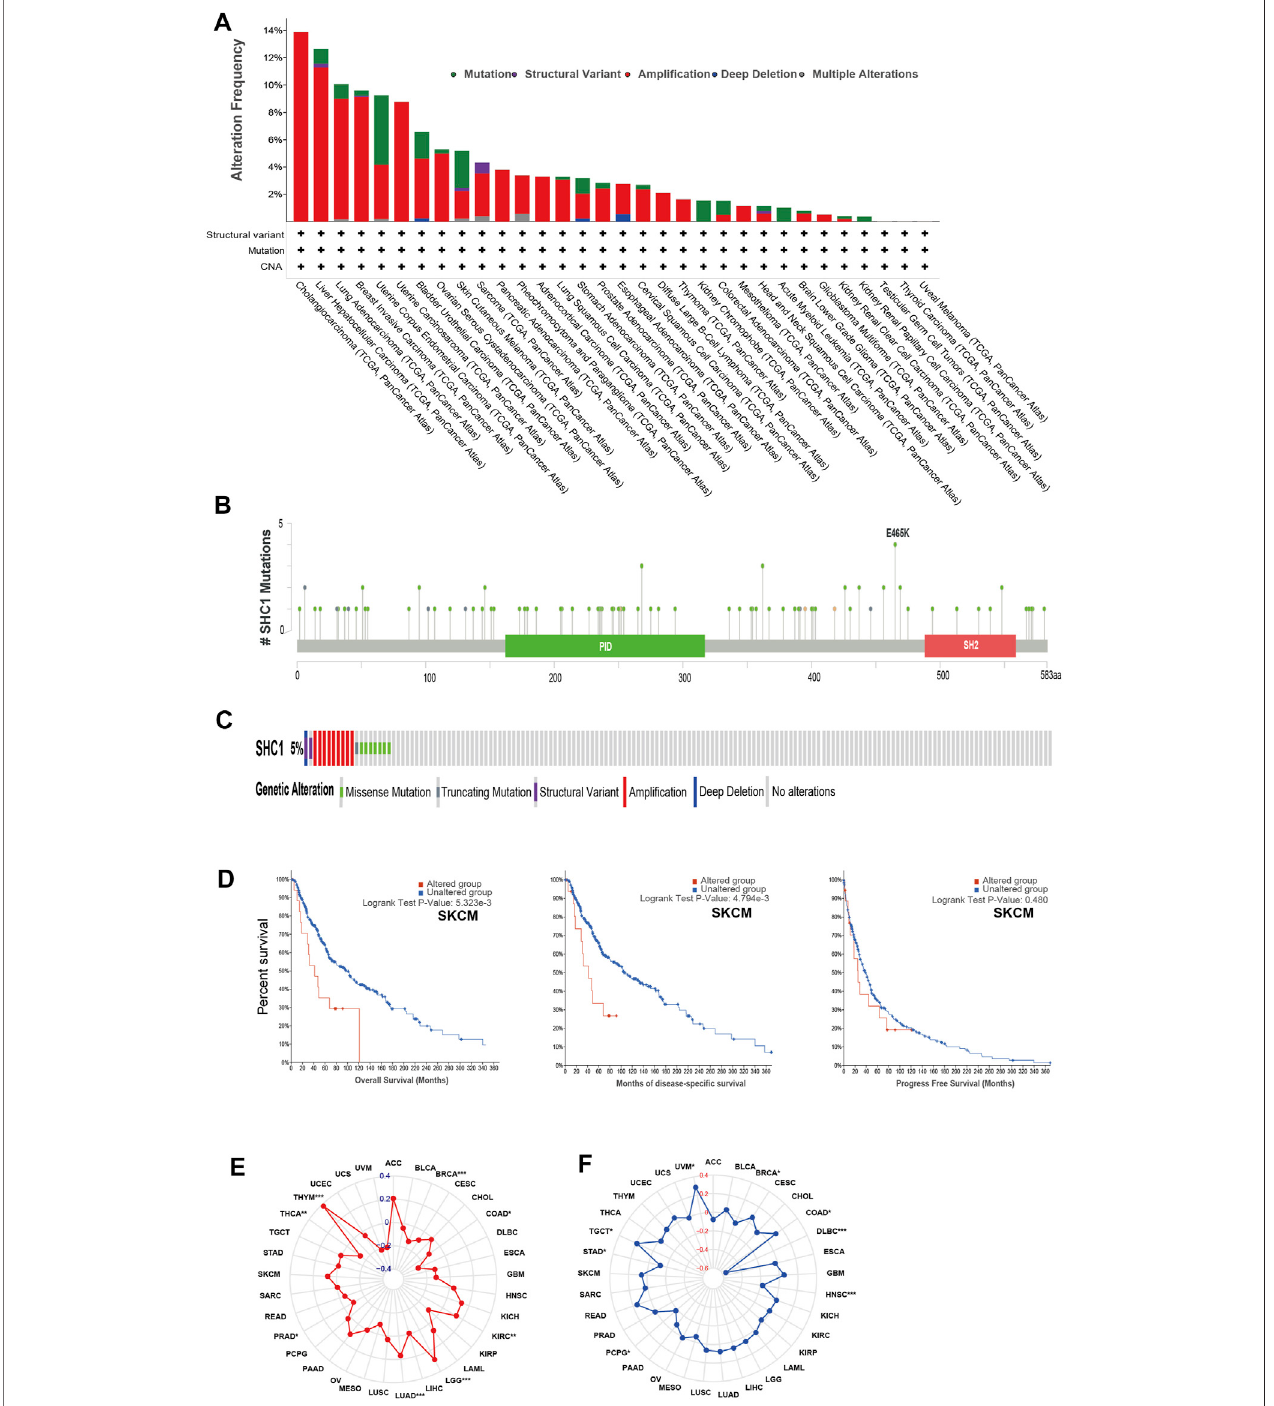
FIGURE 3 | The landscape of mutation signatures of SHC1 in TCGA. The relative frequency of each mutation type (A) and mutation site (B) . (C) OncoPrint visualization of SHC1 alterations. (D) Kaplan – Meier plots showing the comparison of OS, DSS, PFS in cases with/without SHC1 gene alterations in SKCM developed using the cBioPortal tool. The radargram of TMB (E) , MSI (F) , and SHC1 expressions in various cancers. (Spearman Correlation test, p values < 0.05 was considered statistically signi fi cant, * p < 0.05, ** p < 0.01, and *** p < 0.001).